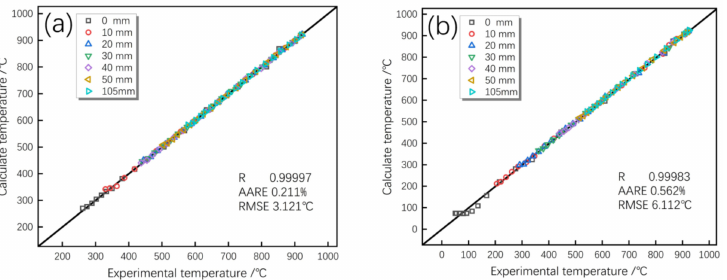
Figure 17. Linear correlation plot of fitted values-experimental values. ( a ) 0.1 MPa compressed air; ( b ) 0.5 MPa compressed air mixed with dry ice